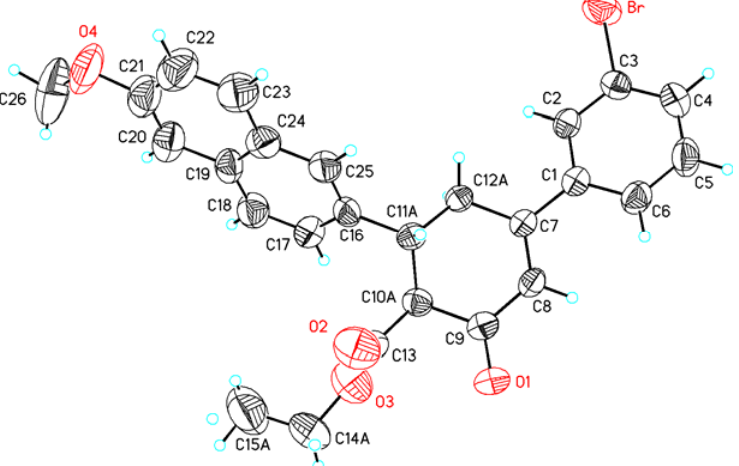
Figure 3. Molecular structure of ( II ) showing the atom labeling scheme and 30% probability displacement ellipsoids. Only the 0.830(6) occupancy disordered atoms are shown. The dihedral angle between the least squares planes of the benzene and naphthalene rings is 64.9(9)°.